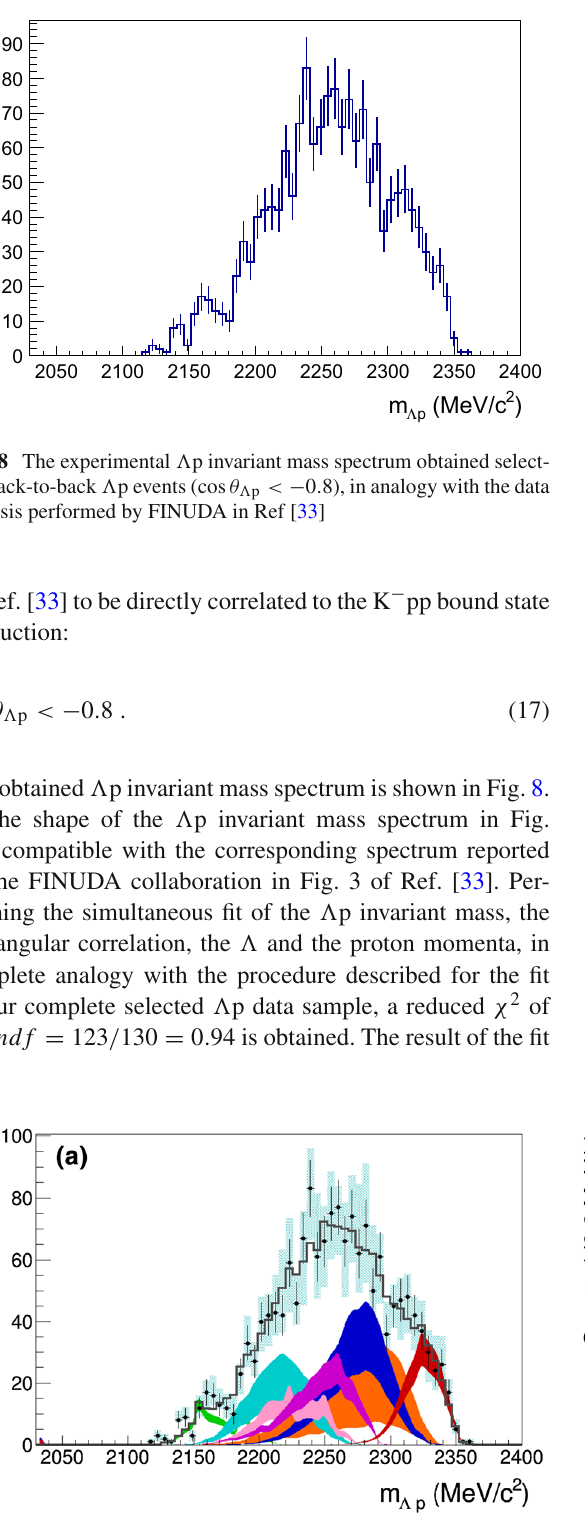
distributions represent the global fitting functions. The color legend for the different contributing processes is shown in the